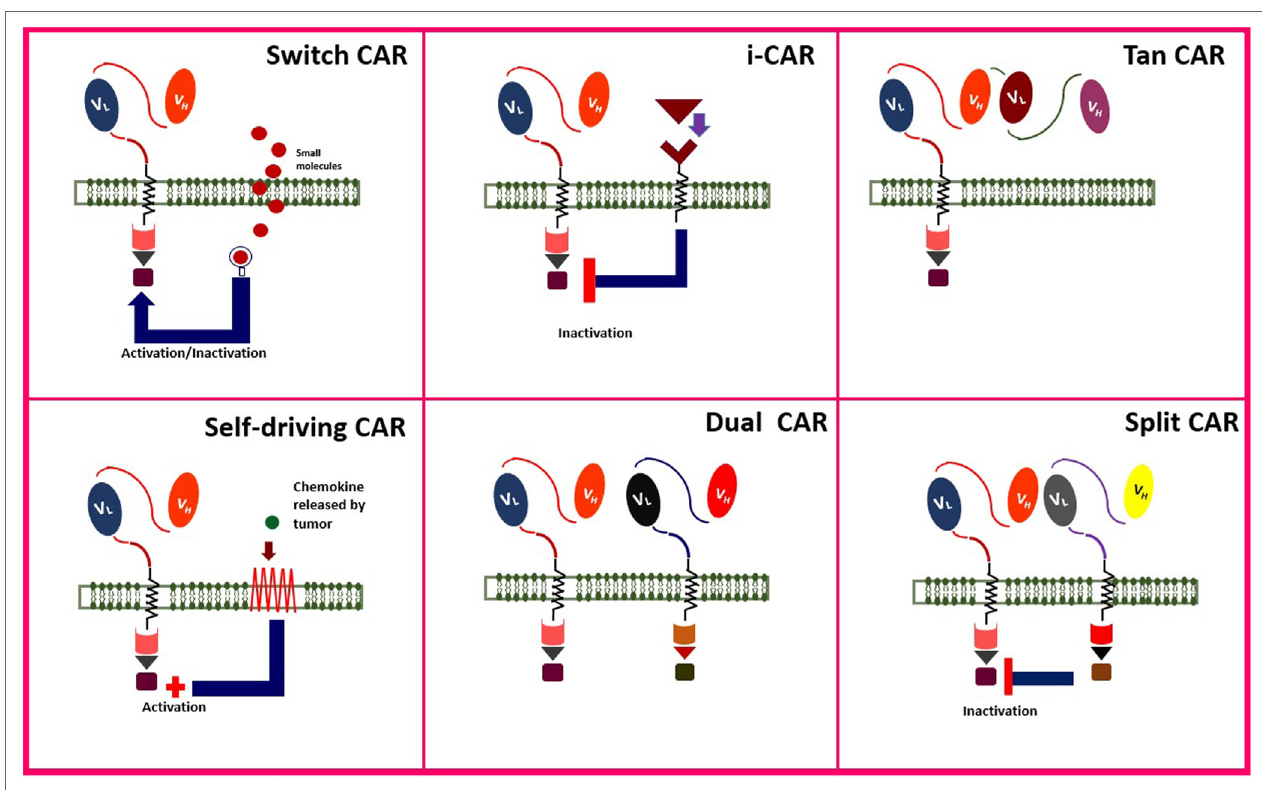
FiGURe 4 | Novel modified chimeric antigen receptor (CAR) designs. Created by Esmaeilzadeh et